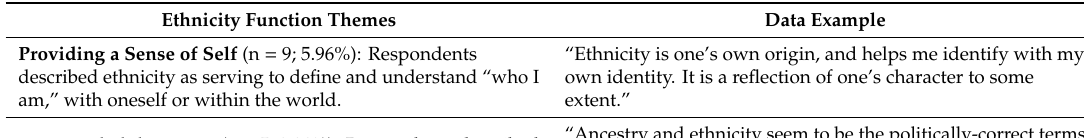
Table 5. Spontaneously o ff ered functions of ethnicity and